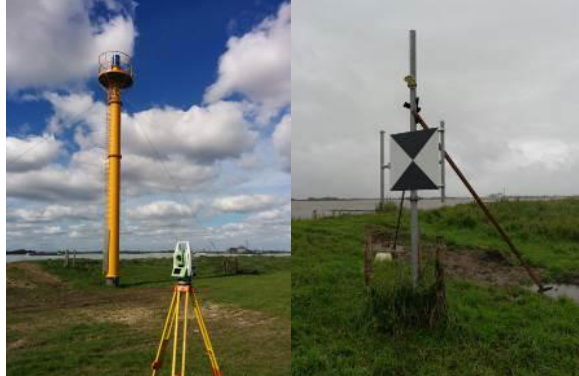
Figure 3. Platform for monitoring system at the bottom of the summer dyke (left), strutted pile with reference target as chess pattern 80×80 cm 2 (right)